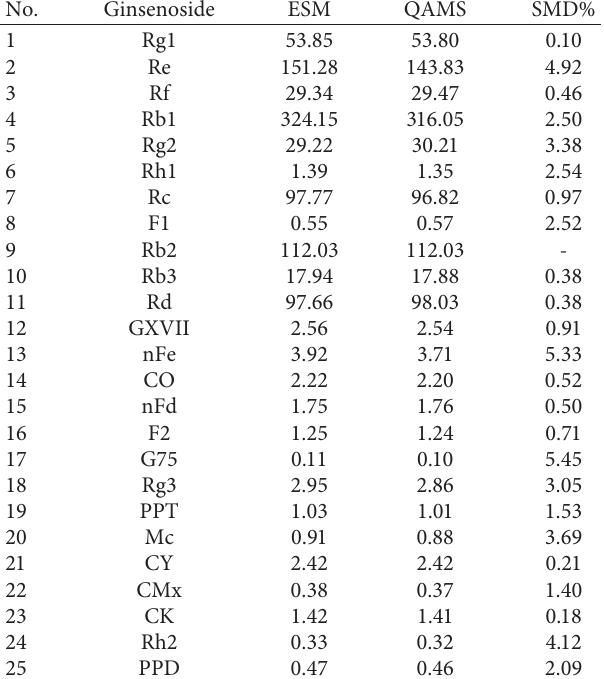
Table 6: Comparative experiment results of the external standard method (ESM) and quantitative analysis of multiginsenosides by single marker method (QAMS)